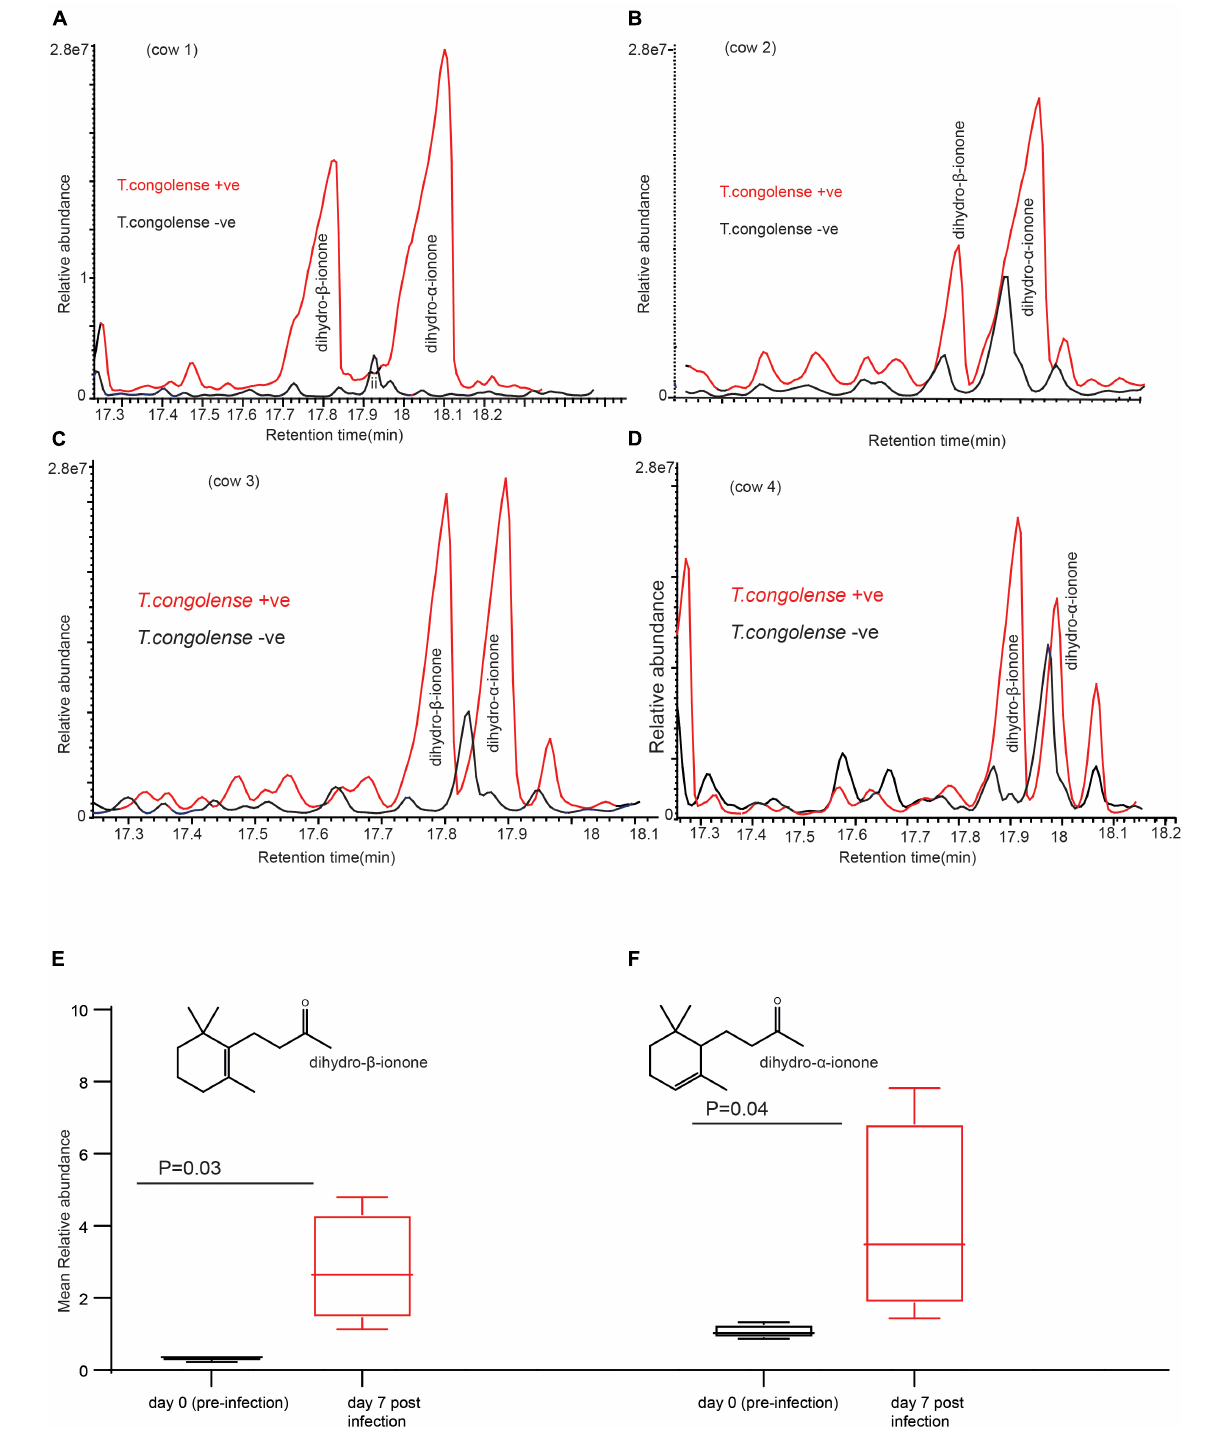
Frontiers in Microbiology |